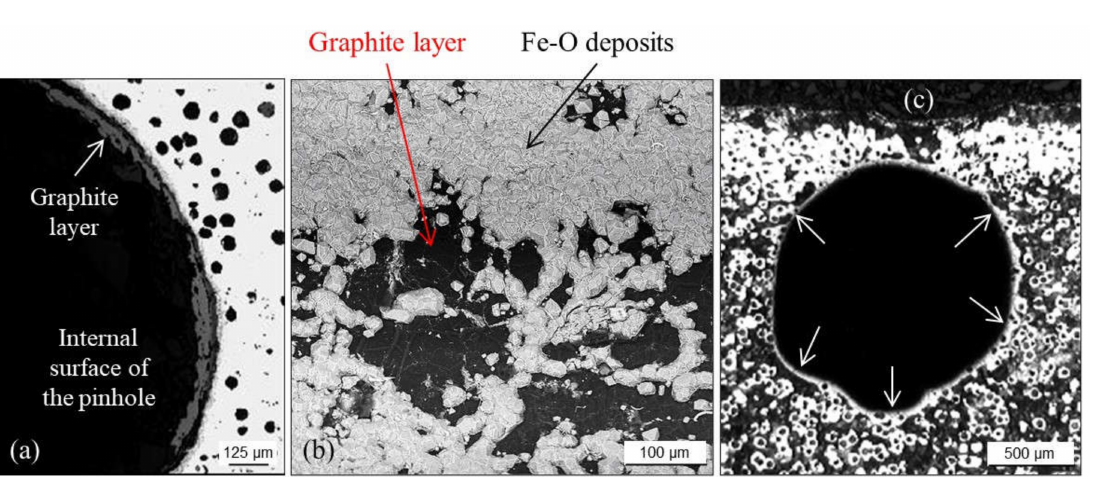
Figure 8. ( a ) Graphite layer on the internal surface of a pinhole found in a ductile iron casting; ( b ) iron oxides found on the graphite layer; ( c ) detail of the matrix close to the internal surface of a pinhole detected in a ductile iron casting.